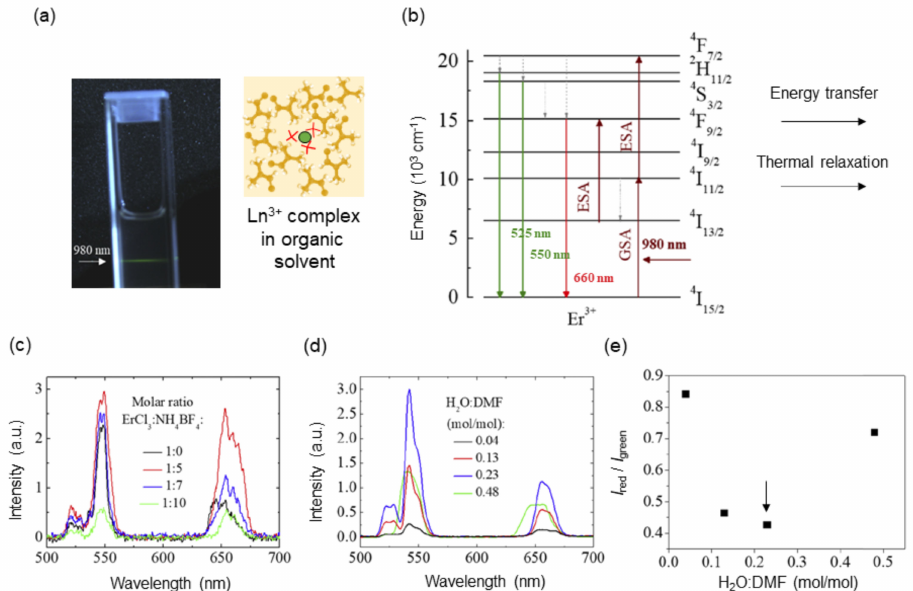
Figure 3. Upconversion luminescence from Er 3+ complexes coordinated with BF − 980 nm irradiation. ( a ) A picture of the Er 3+ complexes (ErCl 3 /NH 4 BF 4 = 1:5) in a cuvette and schematic of Er 3+ coordination complex in organic solvent. ( b ) Energy level diagram of Er 3+ . ( c ) Up- conversion spectra of the Er 3+ coordination complex with different molar ratio of ErCl 3 /NH 4 BF 4 (power: 192 W/cm 2 , solvent: DMF). ( d ) Upconversion spectra of the Er 3+ coordination complexes dispersed in the mixture of H 2 O and DMF at different mixed ratios. ( e ) Red-to-green emission intensity ratio ( I red / I green ) as a function of the solvent mixture ratio. I red and I green correspond to integrated emission intensity in the ranges of 615–700 nm and 500–575 nm, respectively. An arrow indicates an optimum solvent mixture ratio that allows for the least amount of thermal relaxation among all. Adapted from reference [73] with permission. Copyright 2020 Optical Society of America under the terms of the OSA Open Access Publishing